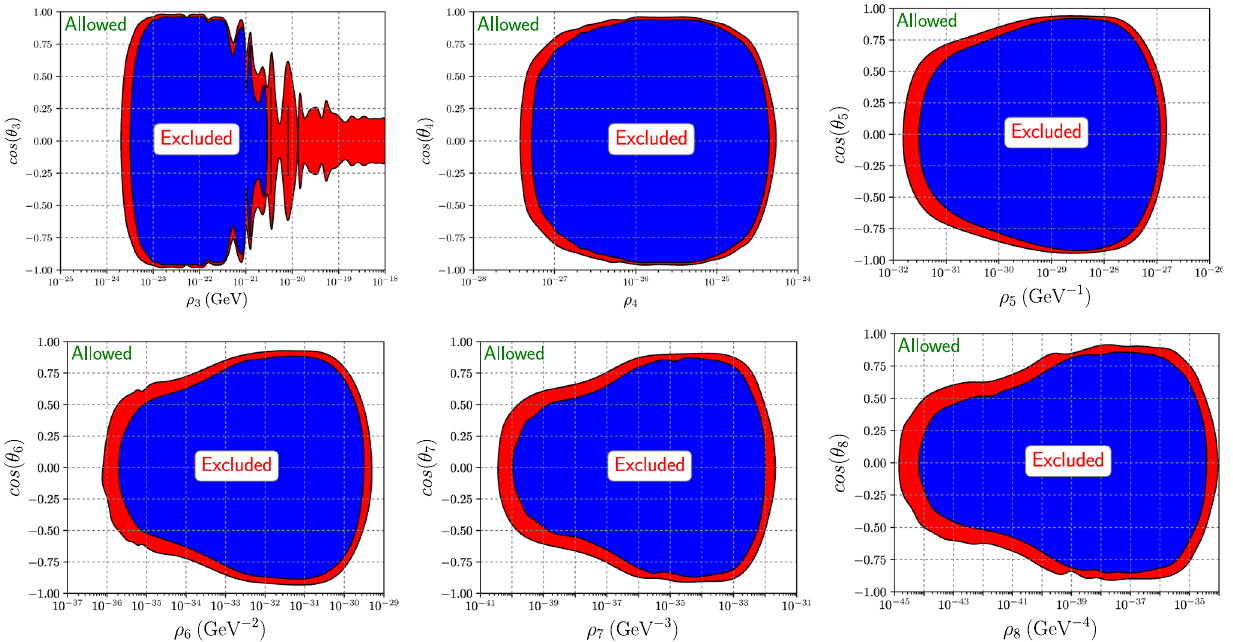
Fig. 18 Exclusion region in the LIV parameter space discussed in the text. The parameter ρ is related to the strength of the Lorentz invari- ance violation. The parameter cos θ is a combination of coefficients that defineLorentzinvarianceviolationintheeffectiveHamiltonianofStan-